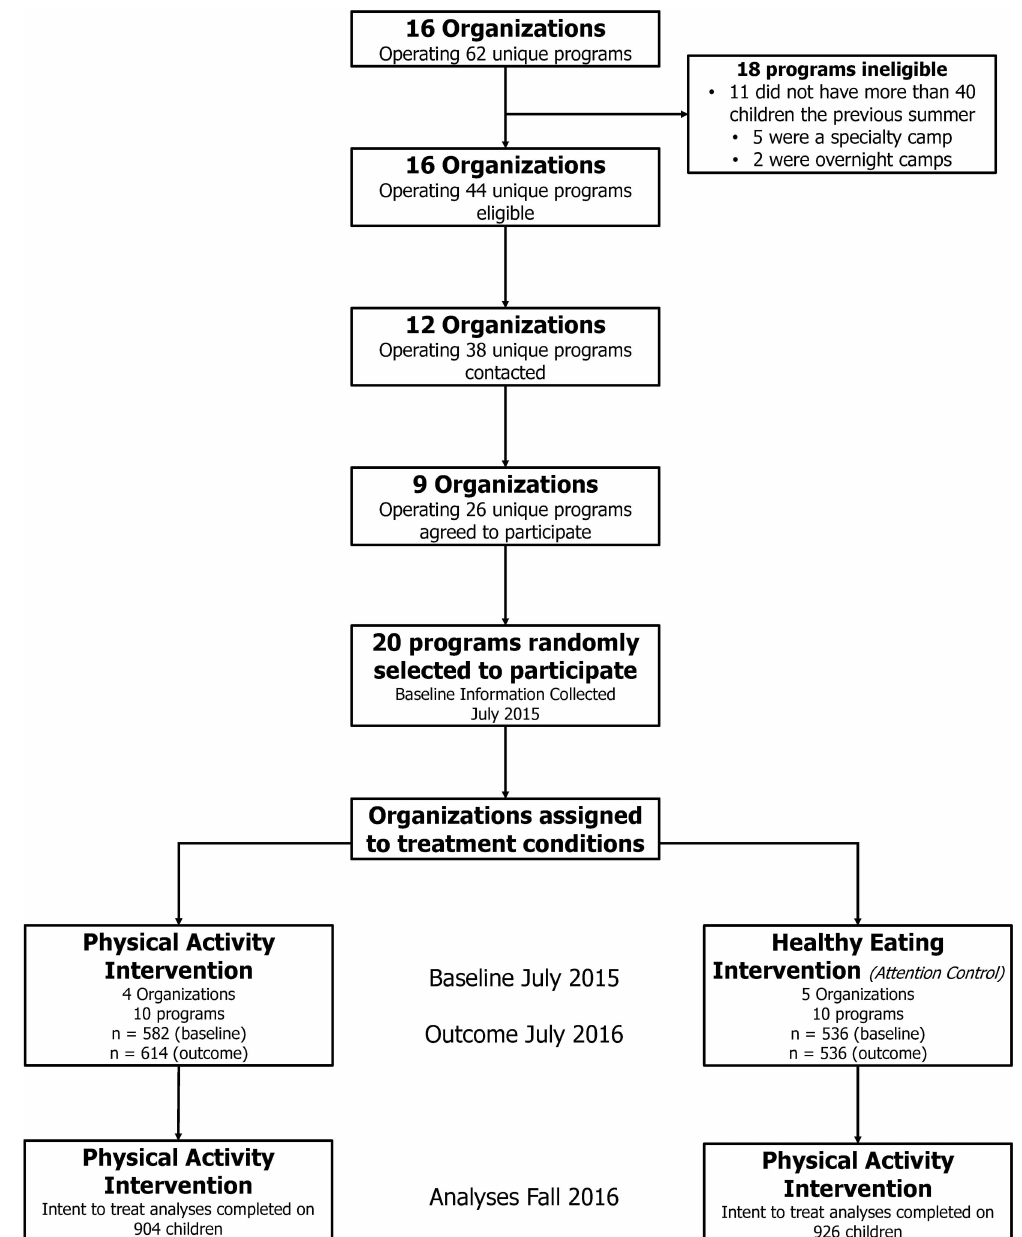
Fig 1. Flow chart of participants for recruitment, data collection, and